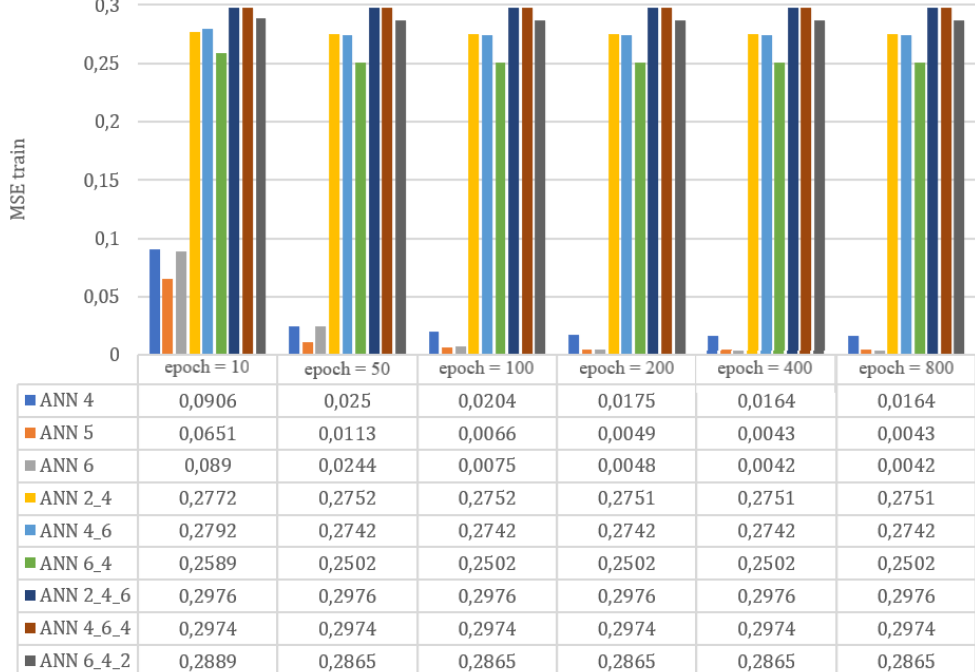
Figure 12. MSE train results of nine different ANN topologies.